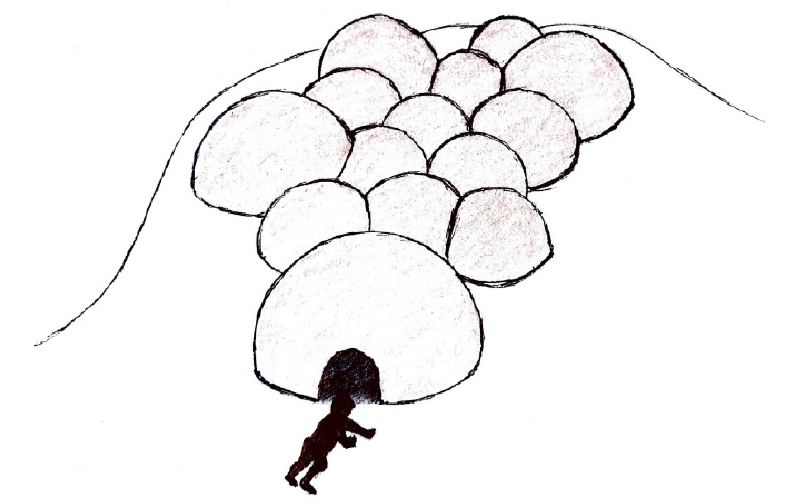
Figure 22. Playground mounds constructed from adobe—sketch.